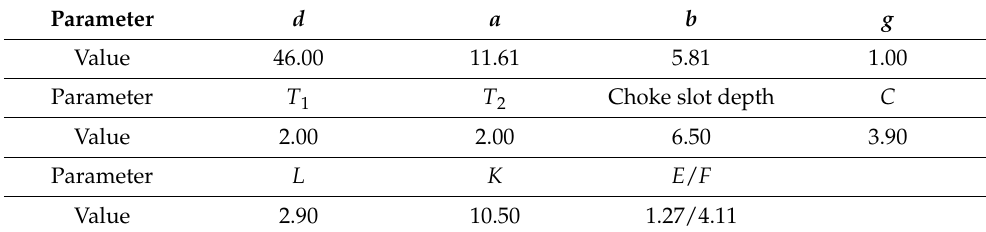
Table 2. Dimensions (mm) of the designed